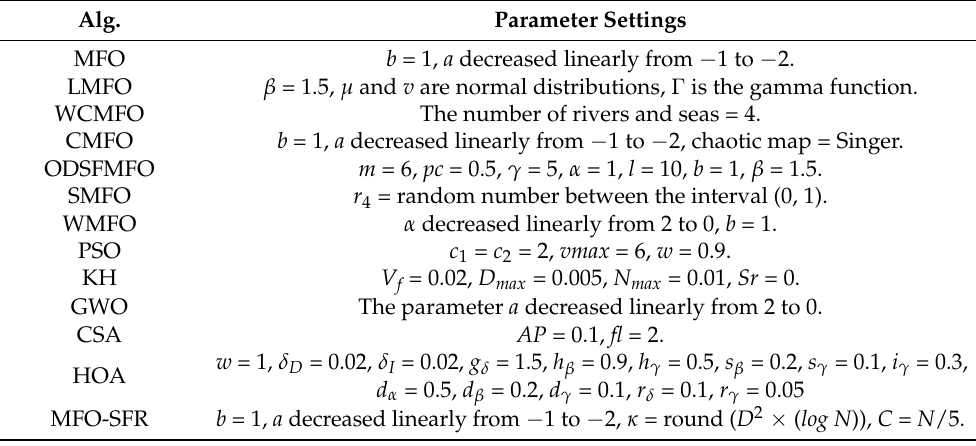
Table 2. Parameter values for the optimization algorithms.